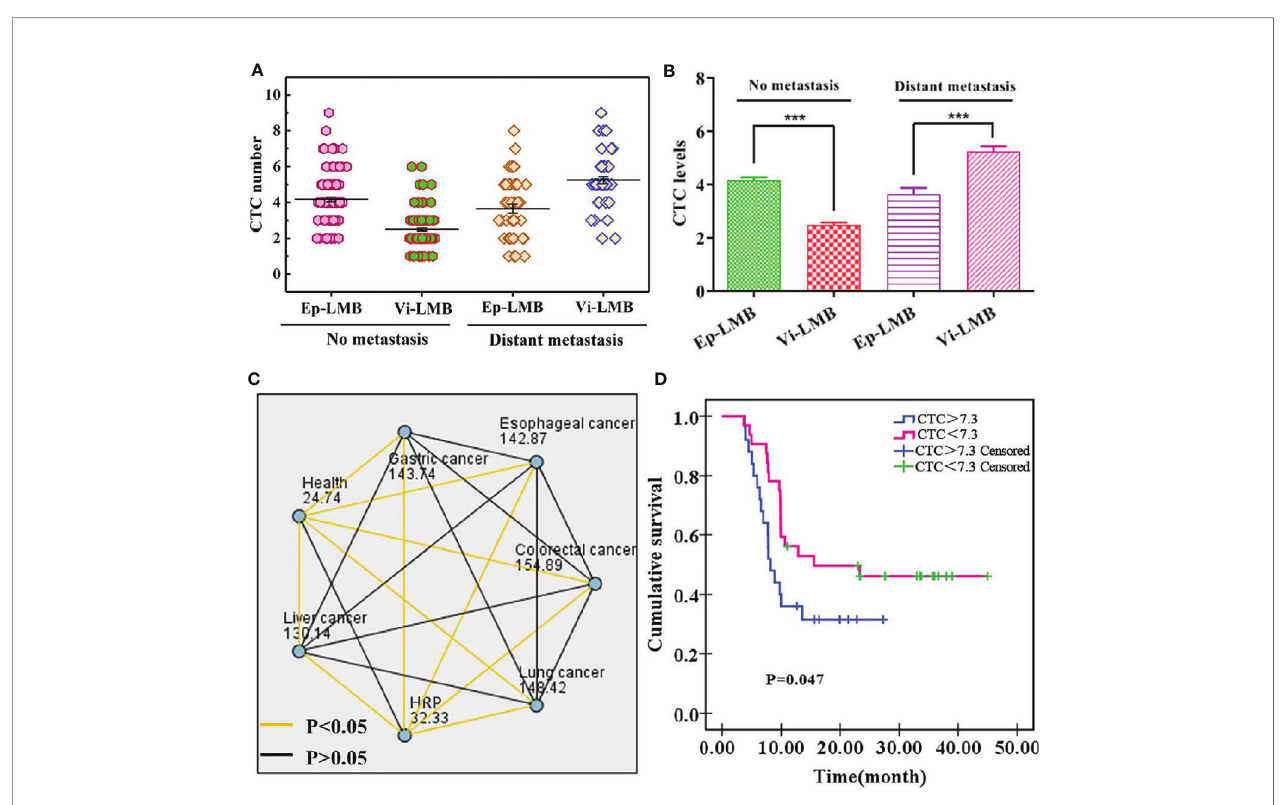
FIGURE 6 | Clinical data of cancer patients: (A) Distribution of Ep-LMB CTCs and Vi-LMB CTCs in blood samples of no metastasis and distant metastasis patients; (B) Comparison of average count of Ep-LMB CTCs and Vi-LMB CTCs in blood samples of no metastasis and distant metastasis patients; (C) Kruskal-Wallis test results between healthy subjects, HRP patients, and cancer patients; (D) Survival curve of HRP patients with cancer and those with cancer alone. ***P <